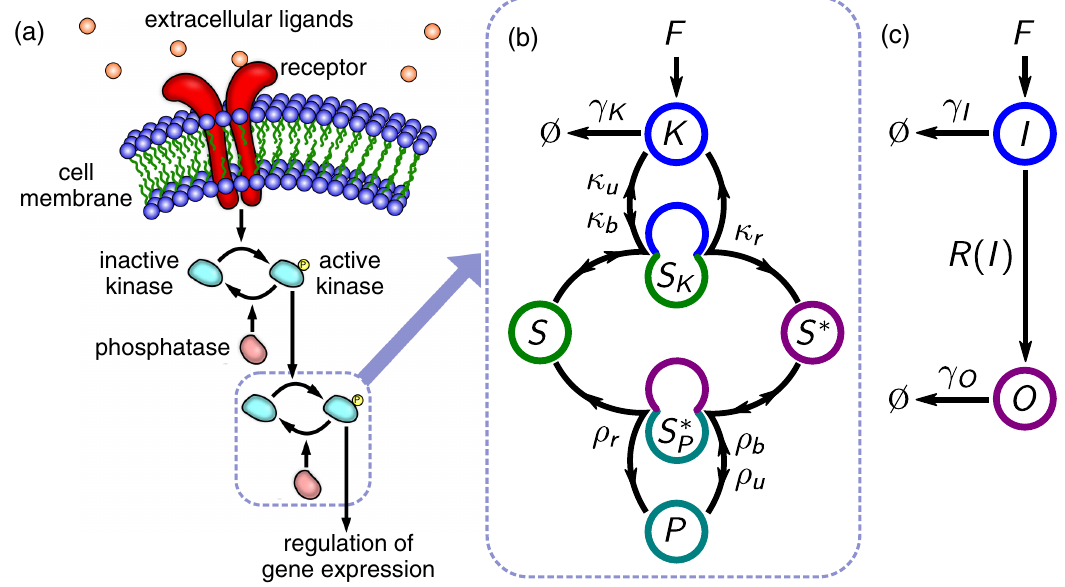
FIG. 1. Schematic of a signaling cascade. (a) A signaling pathway involving cascades of kinase phosphorylation, activated by a receptor embedded in the cell membrane that responds to extracellular ligands. (b) A close-up of one enzymatic push-pull loop within the cascade. Kinase ( K ) phosphorylates the substrate ( S ), converting it to active form ( S (cid:1) ), while phosphatase ( P ) reverts it to the original and S (cid:1) represent the substrate in complex with the kinase and phosphatase, respectively. The rate form through dephosphorylation. S K P parameters labeling the reaction arrows are described in the text. The input I ¼ K þ S and output O ¼ S (cid:1) þ S (cid:1) . (c) A minimal K P signaling circuit, involving an input species I and output species O , related by the production rate function R ð I Þ